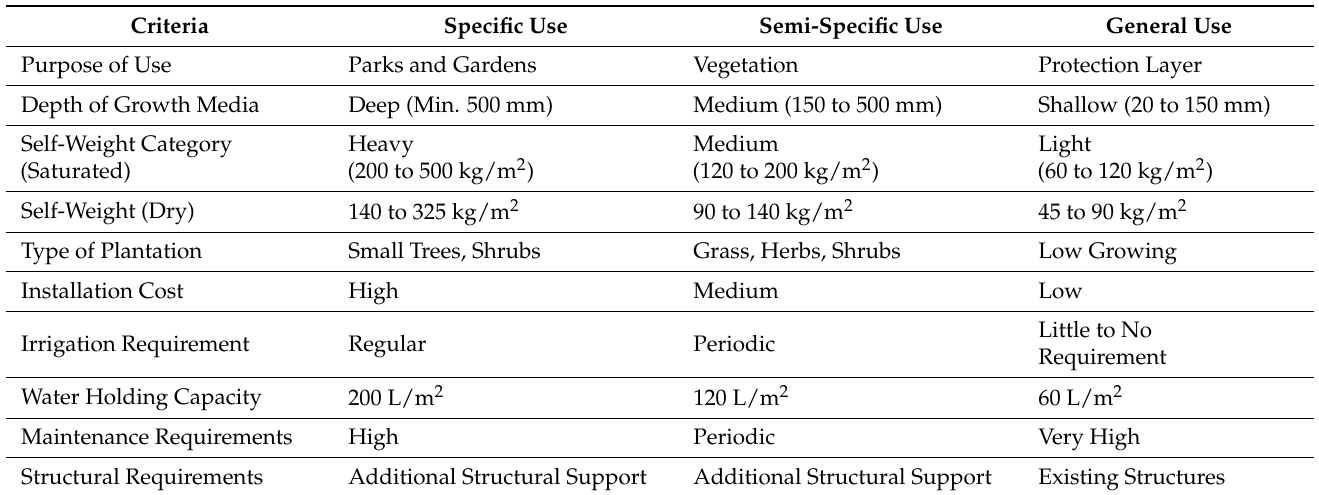
Table 1. Main features of green roof types